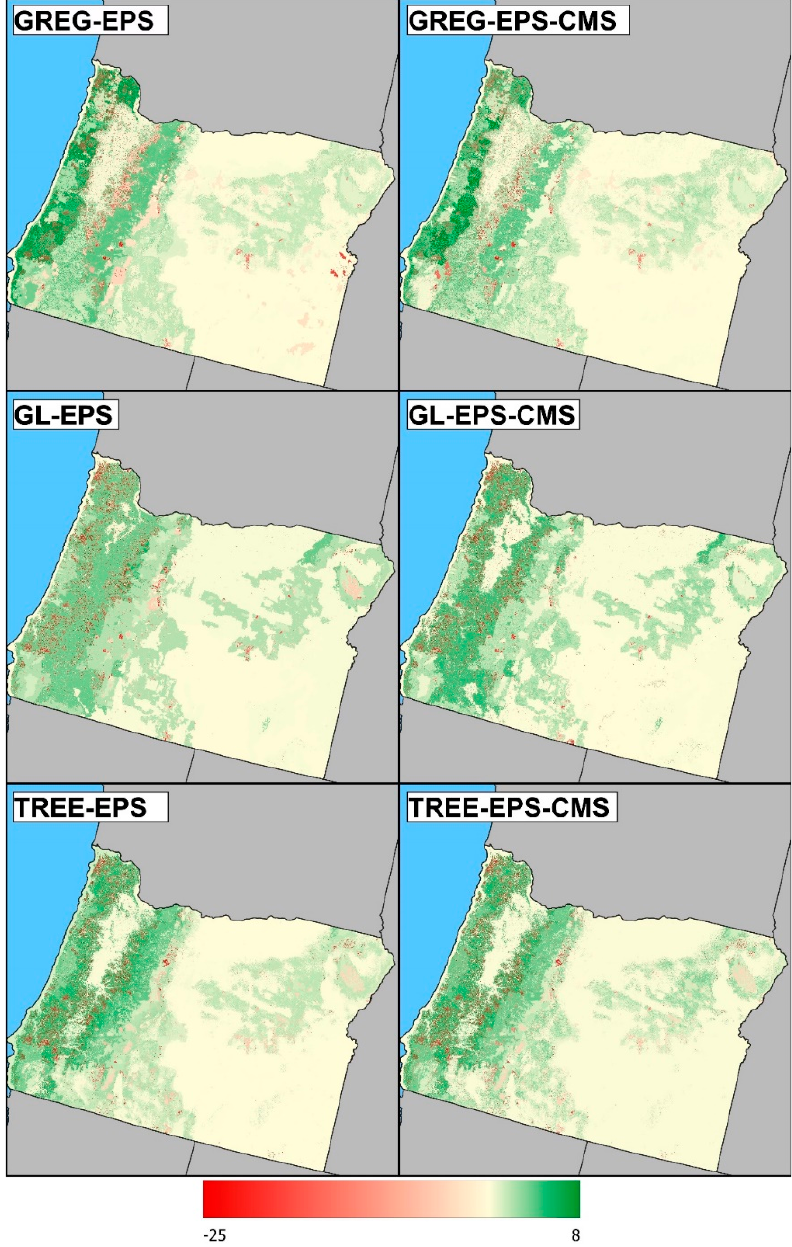
Figure 3. Maps depicting the change in above-ground biomass (AGB) were created using different EPS estimators for the period 2004–2014. Stratum colors were assigned based on the estimated stratum means. Red colors correspond to negative changes in stratum means (i.e., losses in AGB). In addition, green colors correspond to positive changes in stratum means (i.e., gains in AGB).